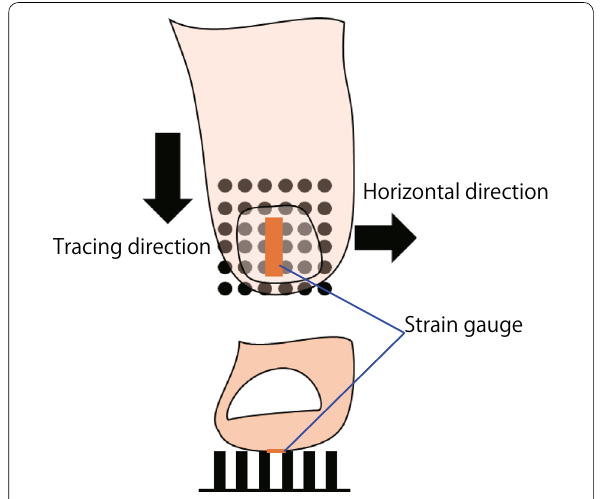
Fig. 2 Finger position on the flexible